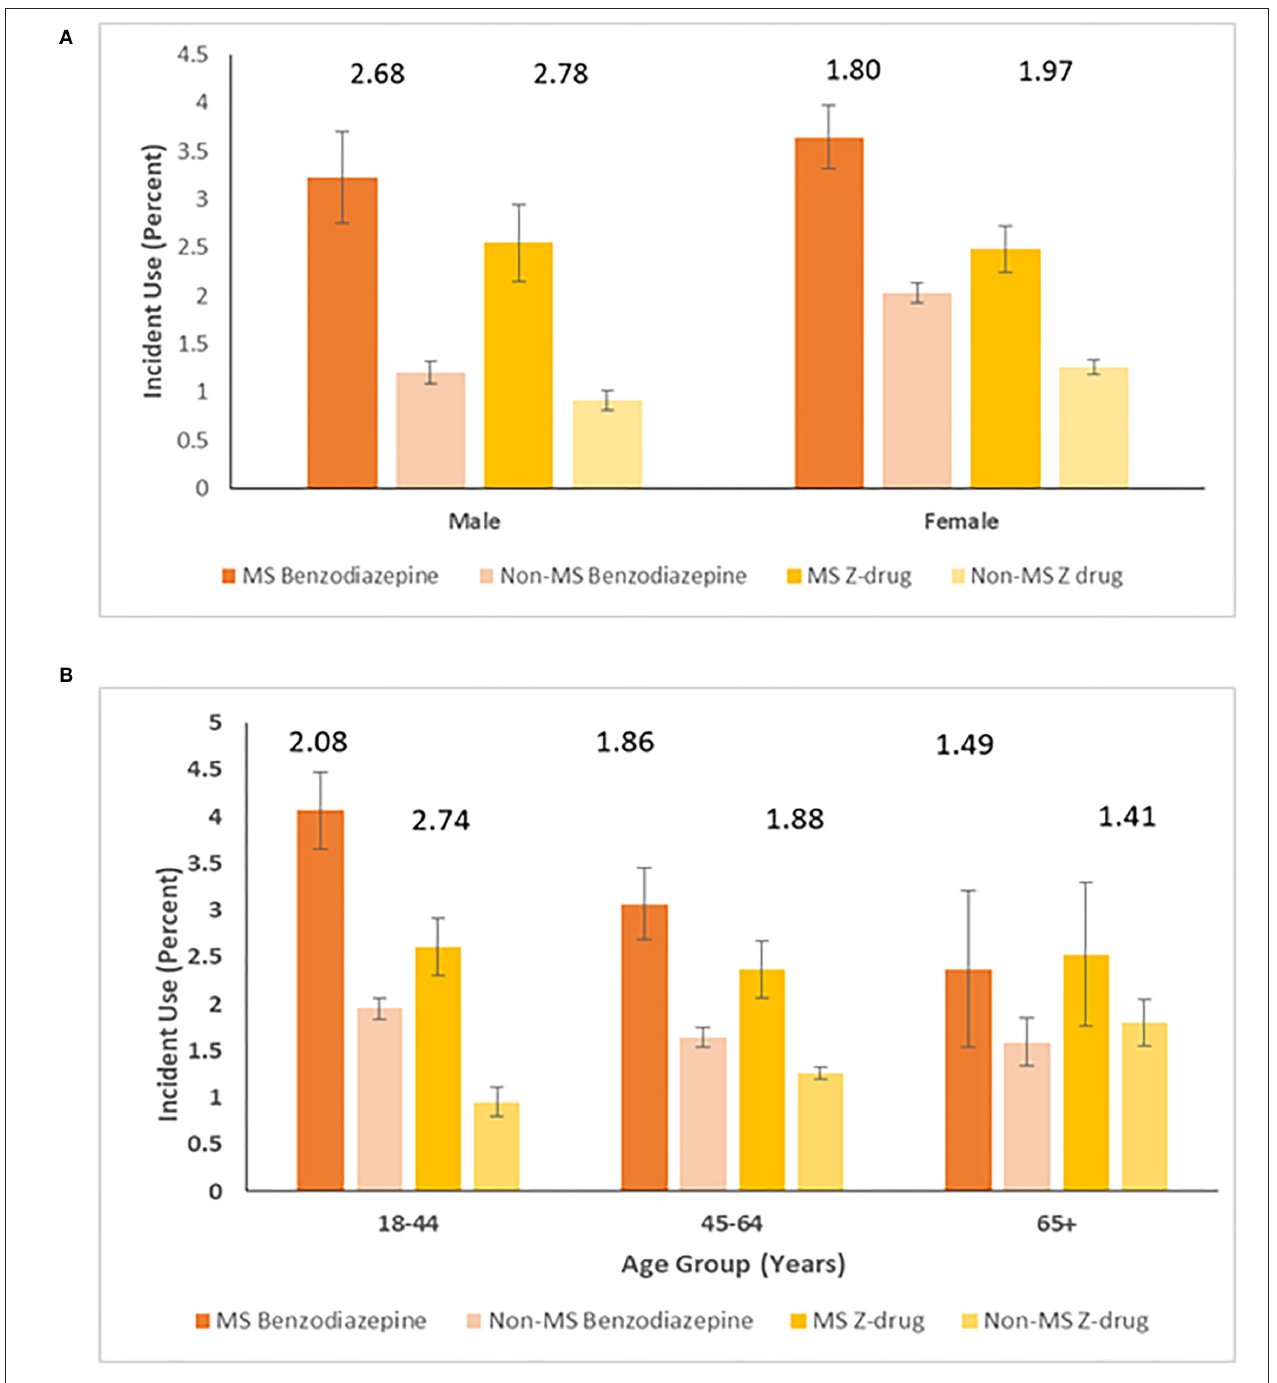
FIGURE 2 | Average annual incidence (95% CI) per 100 person-years of benzodiazepine and Z-drug use stratified by cohort and (A) sex* and (B) age group*. *Numbers above columns represent ratios comparing MS and non-MS cohorts.